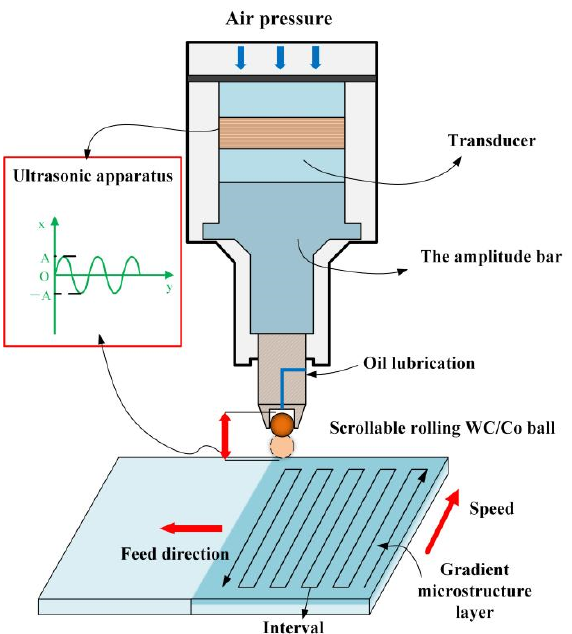
Figure 1. Schematic diagram of the UNSM instrument.